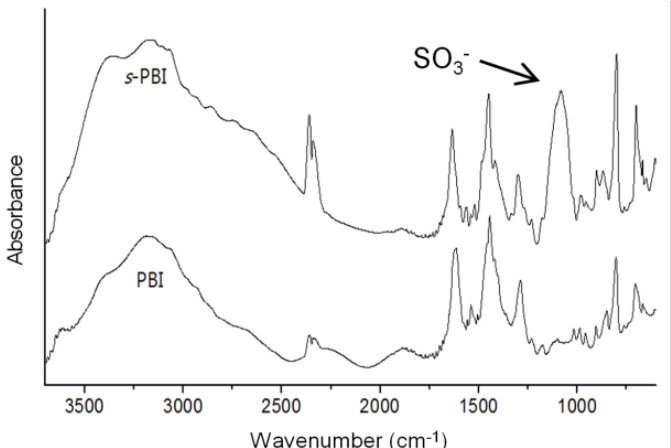
Figure 2. Fourier transform infrared (FT-IR) spectra of polybenzimidazole (PBI) and sulfonated PBI (s - PBI).